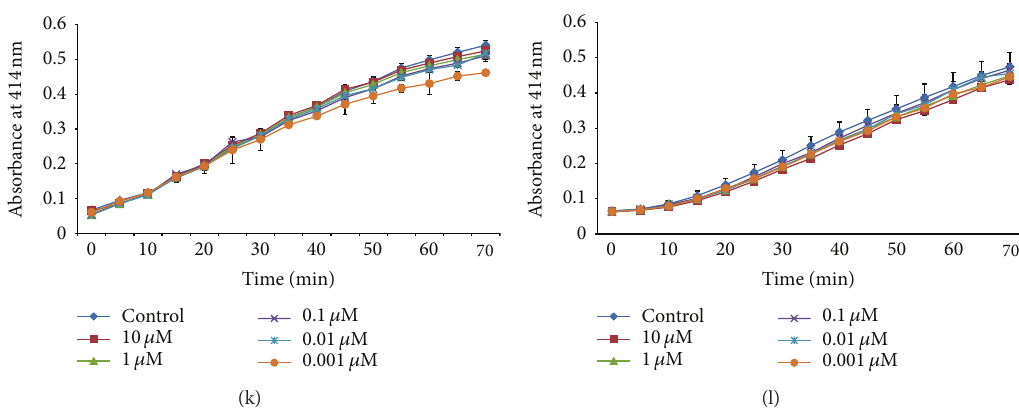
Figure 2: (a) Concentration-dependent peroxyl radical averting ability of trolox. (b) Concentration-dependent peroxyl radical averting ability of 𝛼 -tocopherol. (c) Concentration-dependent peroxyl radical averting ability of nicotinic acid. (d) Concentration-dependent peroxyl radical averting ability of 𝛽 -carotene. (e) Concentration-dependent peroxyl radical averting ability of l-ascorbic acid. (f) Concentration- dependent peroxyl radical averting ability of quercetin. (g) Concentration-dependent peroxyl radical averting ability of n-propyl gallate. (h) Concentration-dependent peroxyl radical averting ability of BHA. (i) Concentration-dependent peroxyl radical averting ability of BHT. (j) Concentration-dependent peroxyl radical averting ability of TBHQ. (k) Concentration-dependent peroxyl radical averting ability of tBHP. (l) Concentration-dependent peroxyl radical averting ability of H 2 O 2